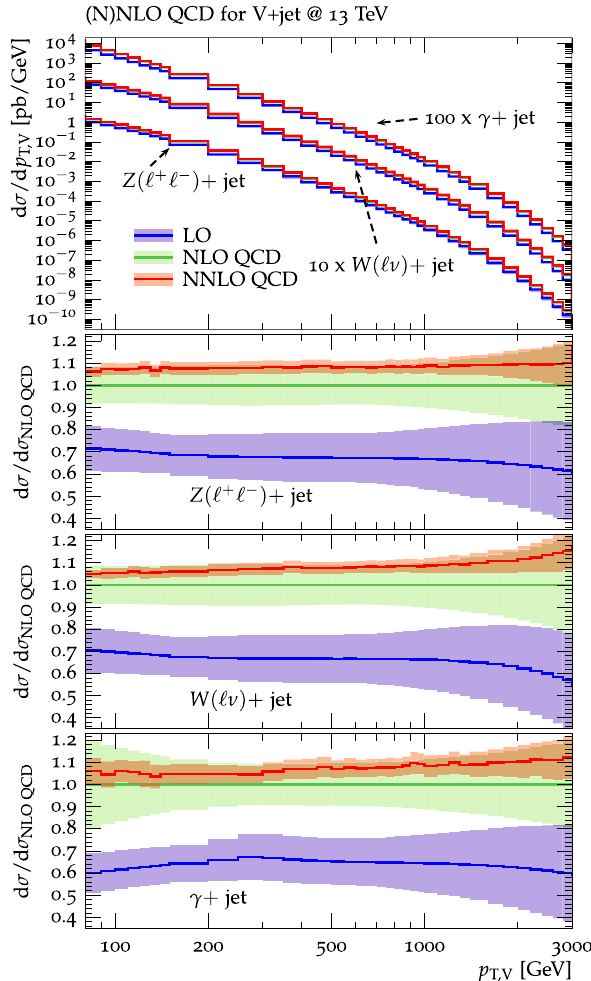
Fig. 6 Higher-order QCD predictions and uncertainties for Z ((cid:3) + (cid:3) − ) + jet, W ± ((cid:3)ν) + jet, and γ + jet production at 13TeV. Absolute predictions at LO, NLO and NNLO QCD are displayed in the main frame. The ratio plots show results for individual processes normalized to NLO QCD. The bands correspond to the combination (in quadra- ture) of the three types of QCD uncertainties, δ ( i ) K N k LO , i.e. scale uncertainties according to Eq. (33), shape uncertainties according to Eq. (35), and process-correlation uncertainties according to Eq.